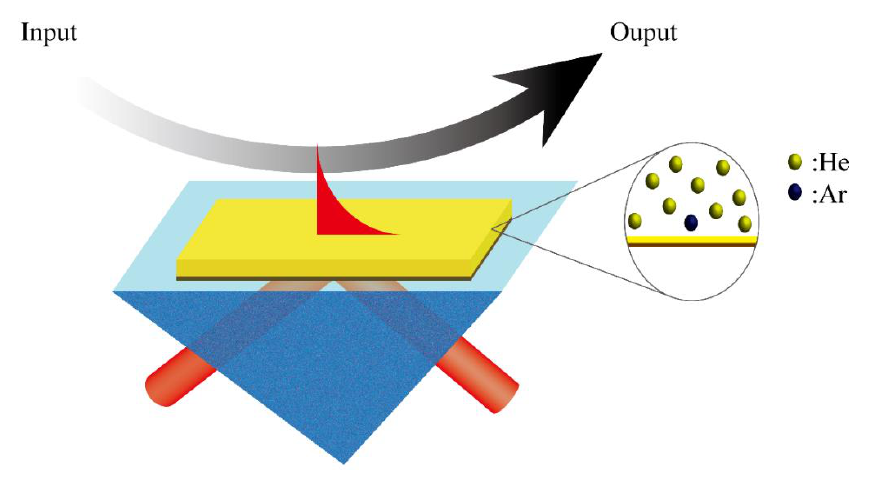
Figure 2. Schematic diagram of the proposed method for detecting inert gas: Kretschmann prism-coupled SPR sensor; enlarged view of a part showing a mixture of helium and argon.